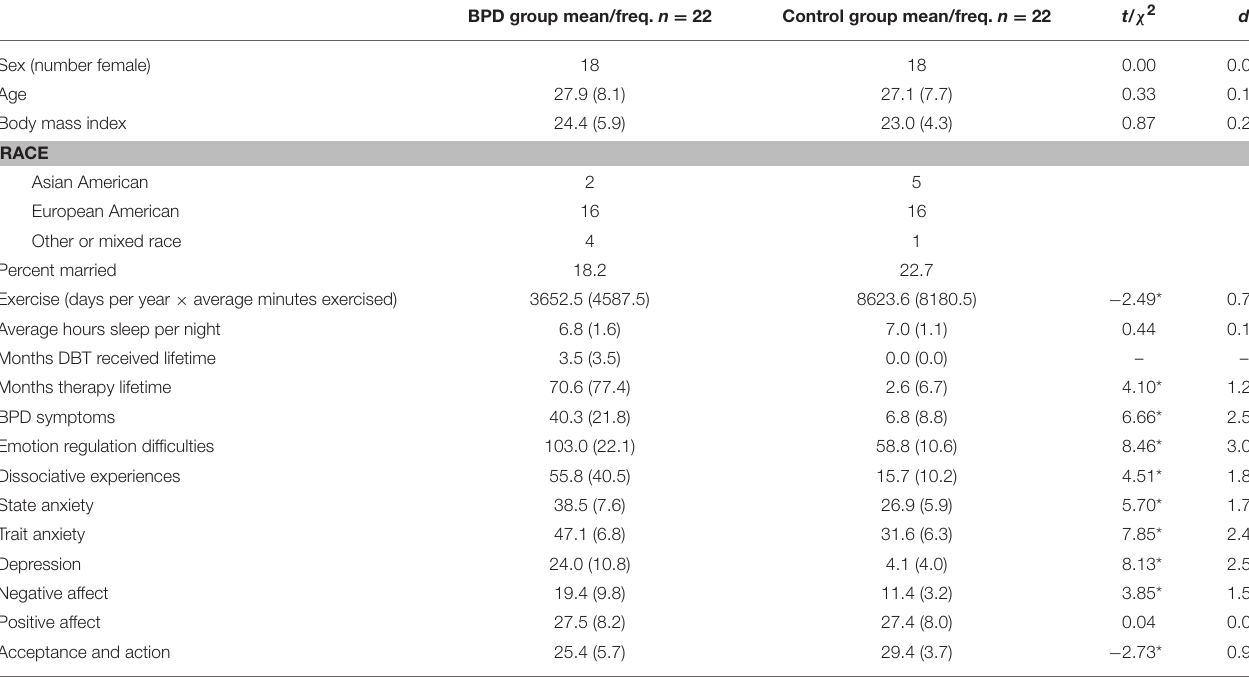
TABLE 1 | Means, standard deviations, and between group differences in participant characteristics and psychological measures by BPD diagnosis group. BPD group mean/freq. n =